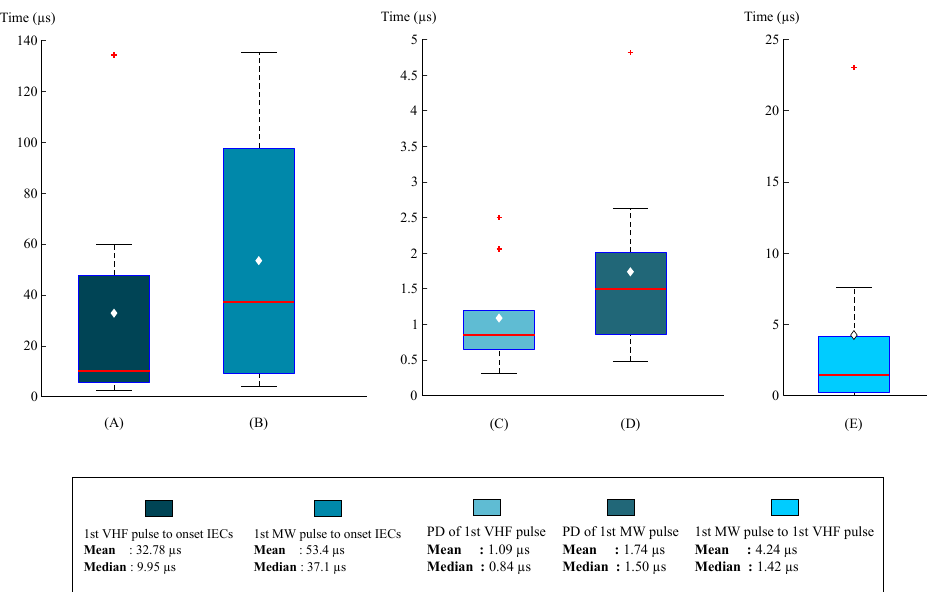
Figure 5. Statistical distribution of temporal analysis for onset time differences; ( A ) between first VHF pulse and the onset IEC, ( B ) between first microwave pulse and the onset IECs, ( C ) pulse duration of the first microwave pulse, ( D ) pulse duration of the first VHF pulse, and ( E ) between first microwave pulse and the onset of first VHF pulse. The mean and median values of each boxplot are shown in the legend box.